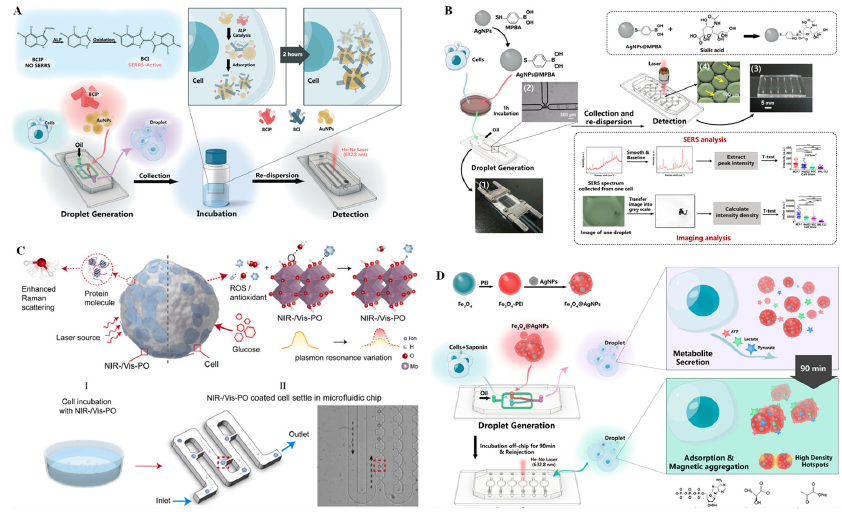
Figure 6. SERS technique for single-cell analysis on microchips. ( A ) Schematic diagram of droplet generation for single-cell encapsulation and an SERRS-based sensor for single-cell ALP activity analysis on a microfluidic chip. Reprinted with permission from ref. [73], Copyright 2019, Royal Society of Chemistry. ( B ) Schematic overview of a microfluidic droplet-integrated SERS sensing platform for SA analysis at the level of a single living cell with the help of plasmon AuNPs. Reprinted with permission from ref. [75], Copyright 2019 Springer Nature. ( C ) Schematic illustration of the enhanced Raman scattering of protein molecules from a single cancer cell by a plasmonic oxide nanoprobe. Reprinted with permission from ref. [76], Copyright 2021, Elsevier B. V. ( D ) Schematic illustration of a microdroplet integrated with an Fe 3 O 4 @AgNP-based SERS sensing platform for the measurement of three different metabolites secreted by a single cell. Reprinted with permission from ref. [77], Copyright 2019 American Chemical Society.